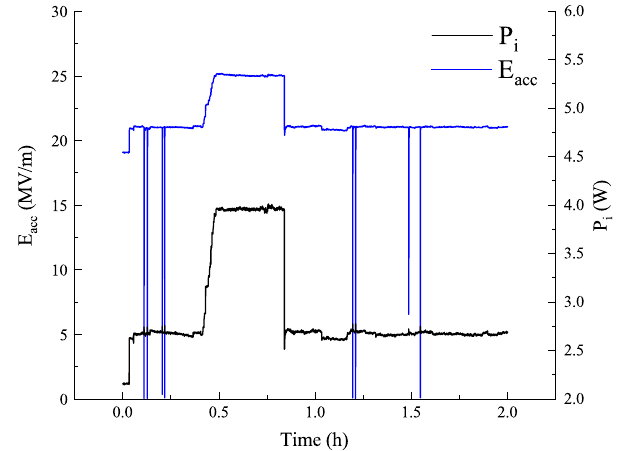
FIG. 7. Data taken during a vertical test of a single cell 1.3 GHz cavity. The rapid drops in gradient indicate when quenching occurred. P is the cavity input rf i